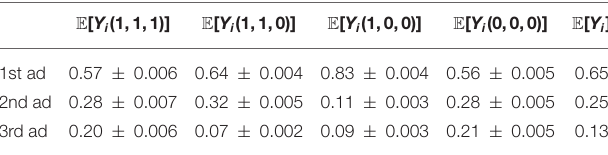
TABLE 1 | Estimated values for the counterfactual mean E [ Y i ( a )] for all possible a , along with the 95 % confidence intervals. E [ Y i